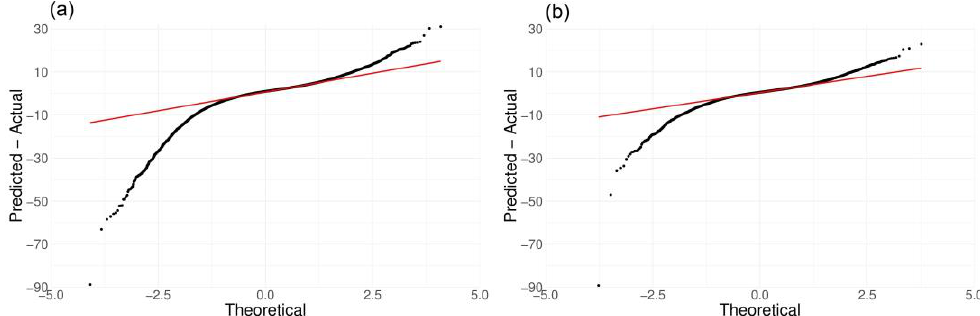
Figure 4. Quantile – quantile plots, showing ( a , c ) density plots and ( b , d ) differences between values predicted by the RF model for surface NO 2 mass concentrations and actual surface NO 2 mass concentrations: ( a , b ) hourly measurements; ( c , d ) weekly averages.